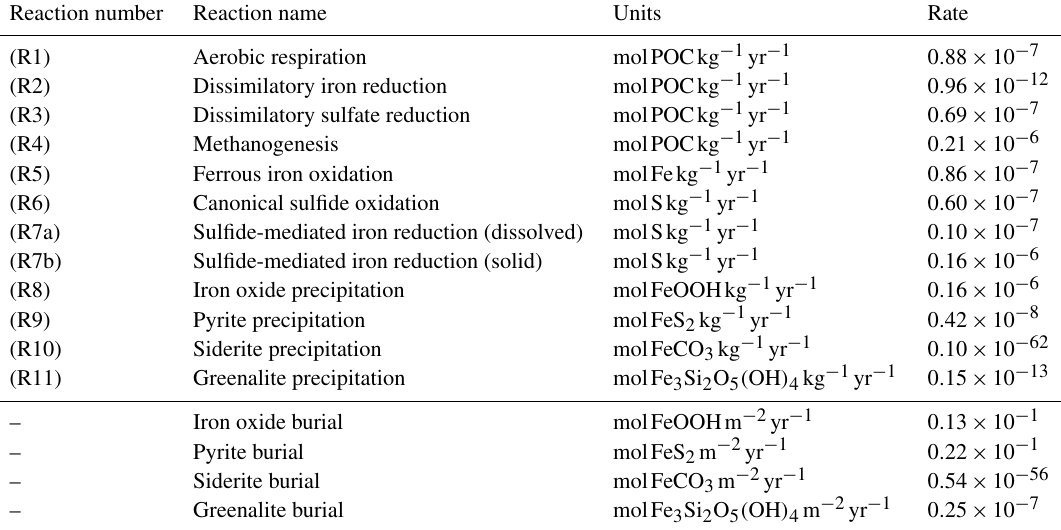
Table 6. Globally integrated reaction rates and burial fluxes for our benchmark simulation. Reaction